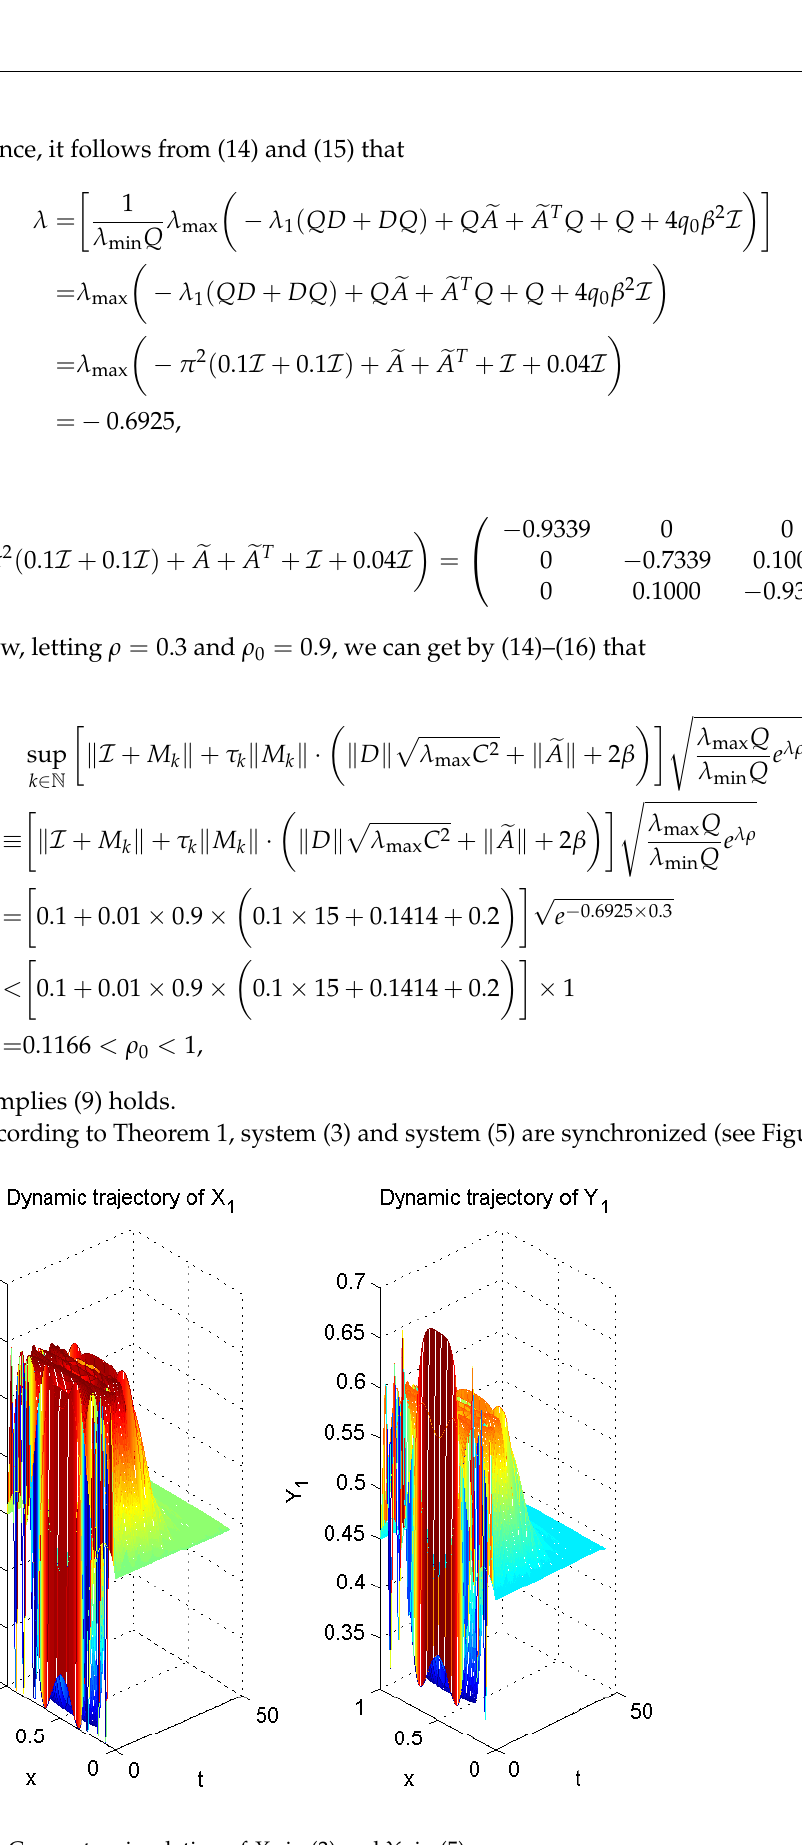
Figure 1. Computer simulation of X 1 in (3) and Y 1 in